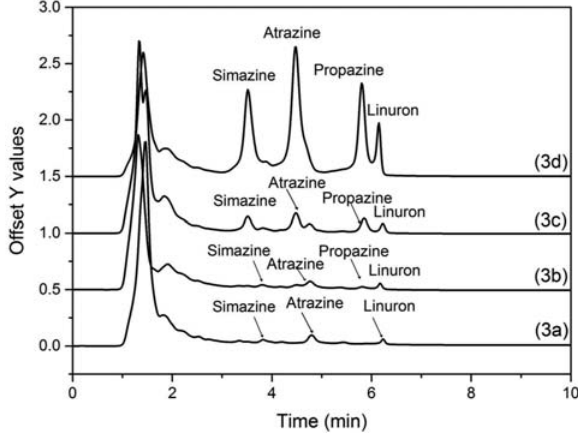
Figure 2. Chromatogram obtained for the separation of selected herbicides by (a) direct HPLC injection and (b) after preconcentra- tion using ILSFOD-LLME combined with HPLC: concentration of all standard herbicides was 500 μg kg –1 .